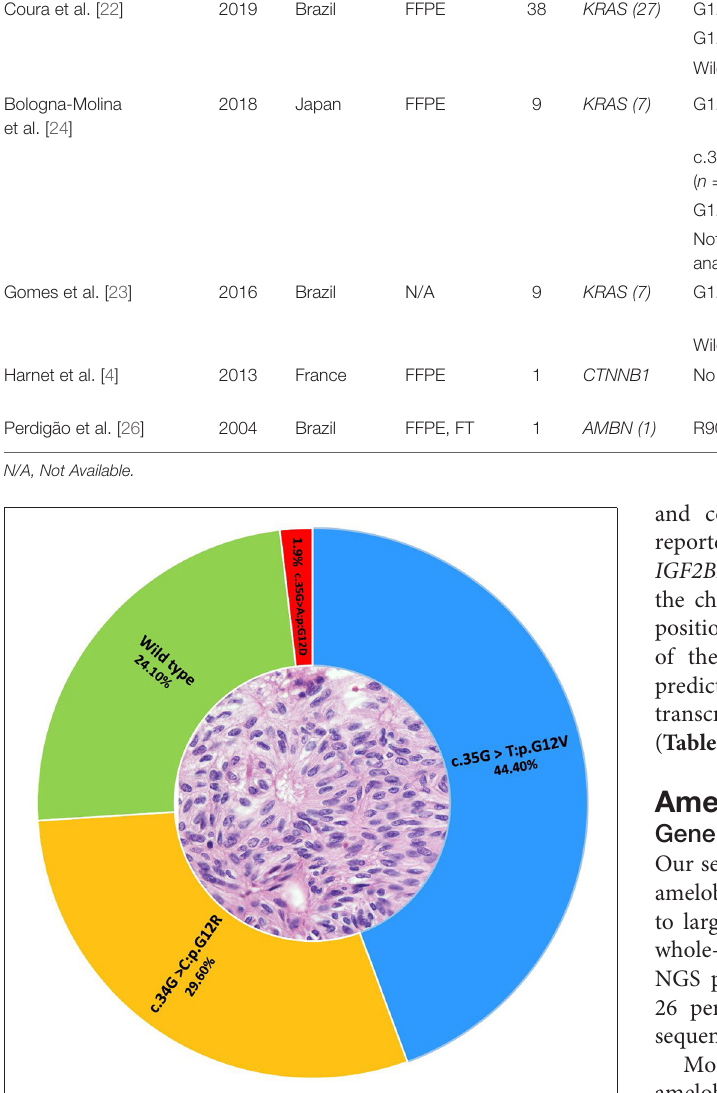
FIGURE 2 | A total of 54 AOTs were assessed for KRAS mutations. The KRAS G12V mutation was identified in 24 cases, G12R in 16 cases and G12D in one tumor. The remaining 13 cases corresponded to wild type